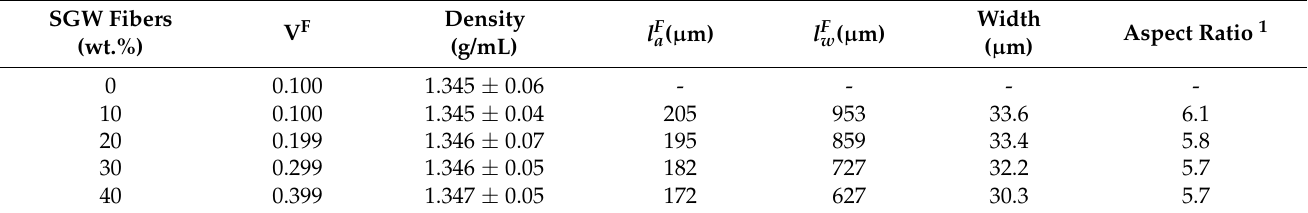
Table 6. Physical properties of composites and morphological analysis of extracted